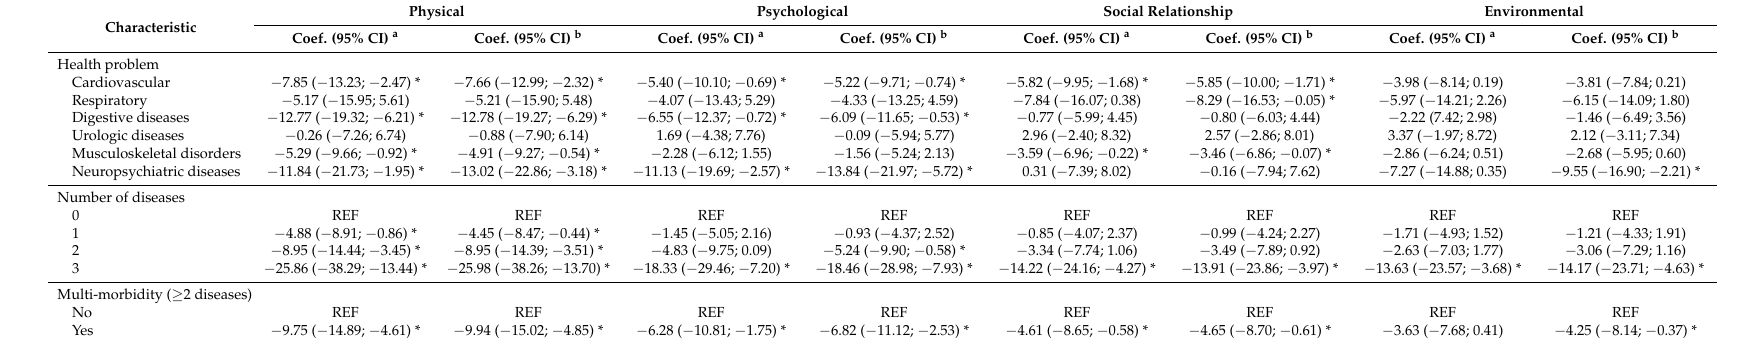
† Difference between respondents with and without health conditions/diseases. * p < 0.05. Table 5. Correlations between WHOQOL-BREF domain scores and